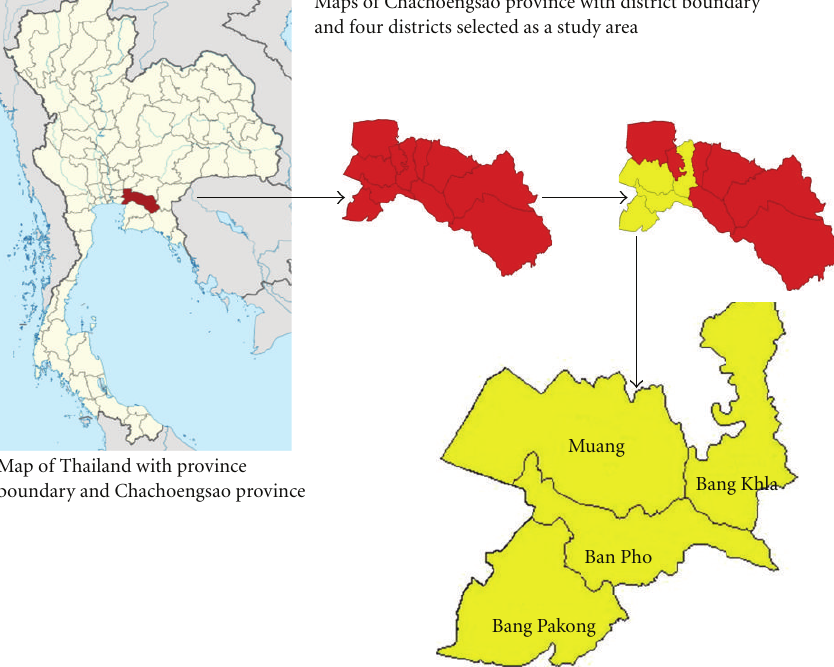
Figure 1: Maps of study area: 4 districts including Muang, Bang Pakong, Ban Pho, and Bang Khla. Map of Thailand obtained from http://www.wikimedia.org/.